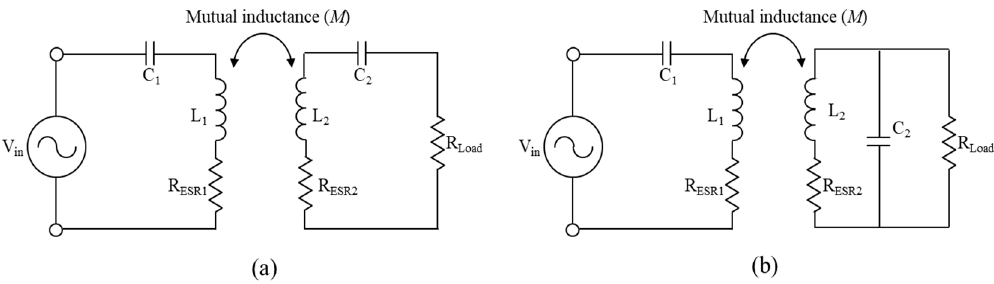
Figure 5. Equivalent circuit of the WPT topology showing the series connection on the transmitting part. ( a ) Series–series topology; ( b ) series–parallel topology.